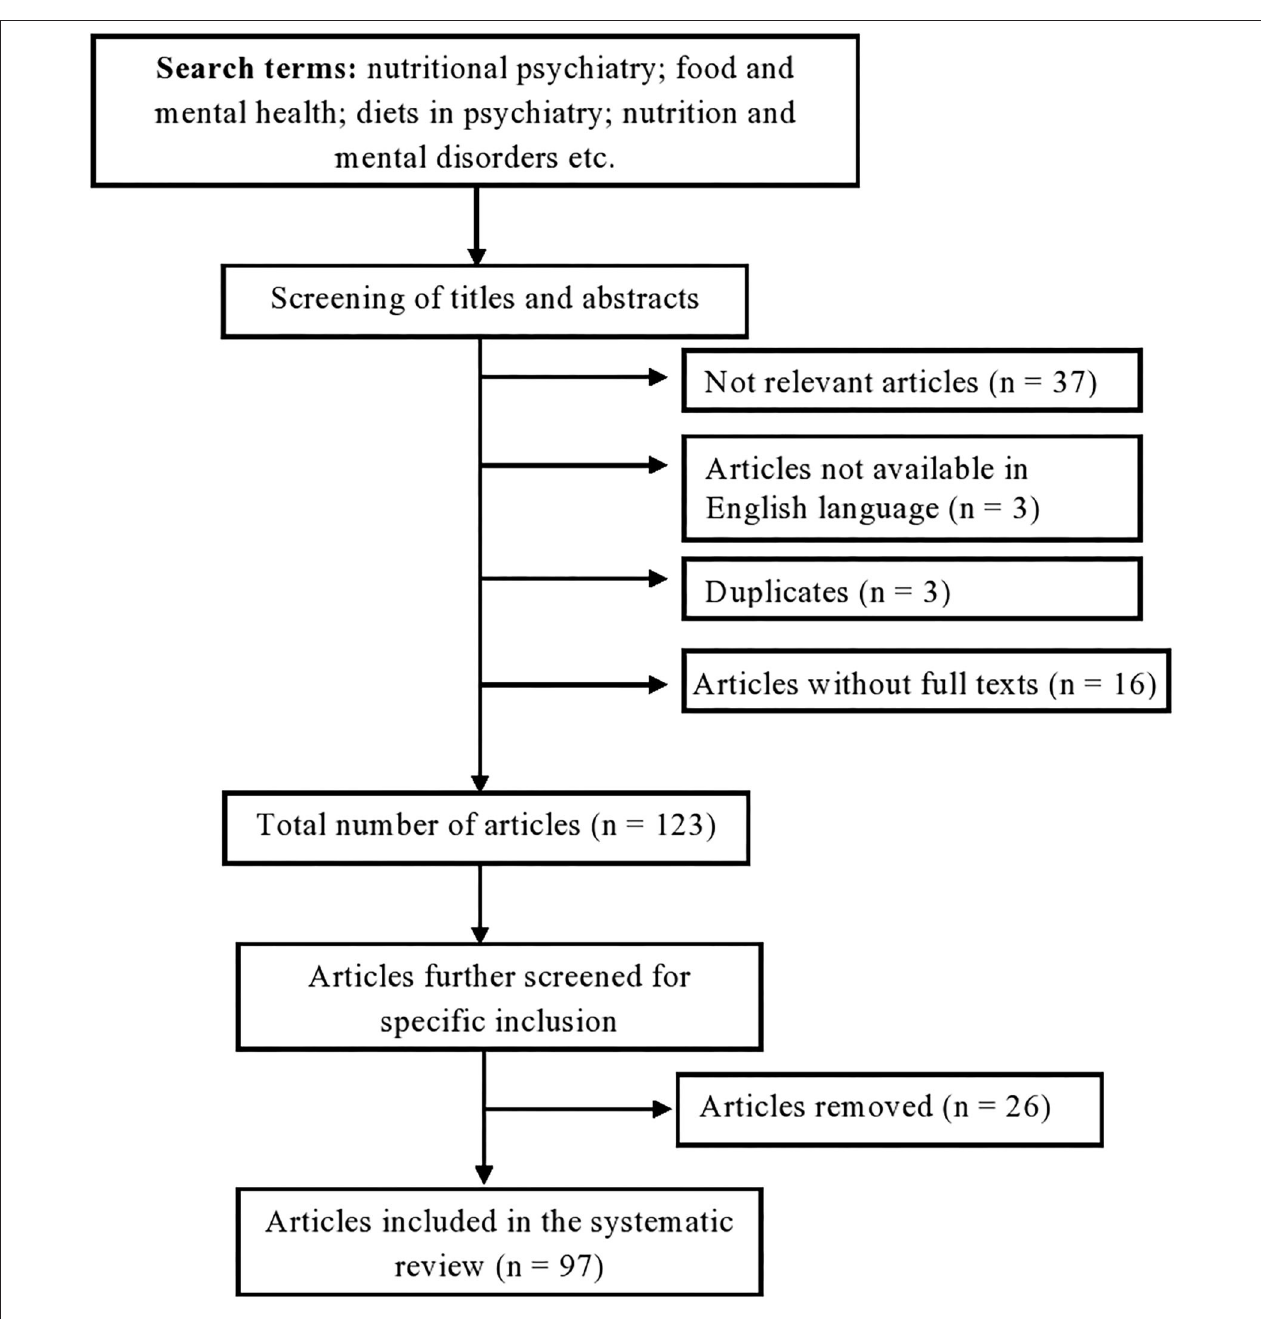
FIGURE 1 | Flow diagram of search selection